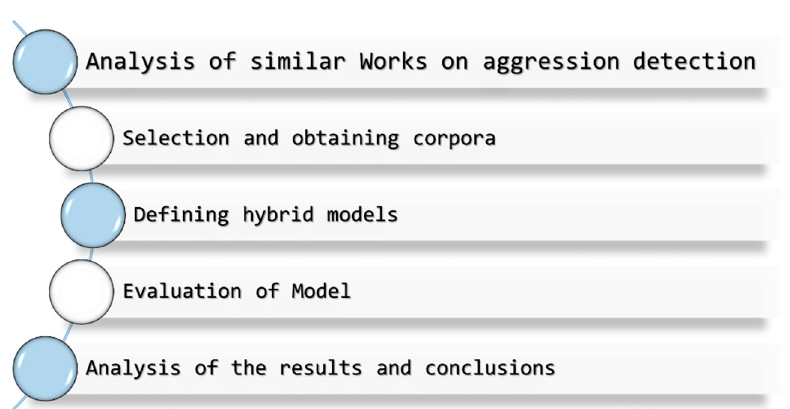
Figure 1. Methodology used.